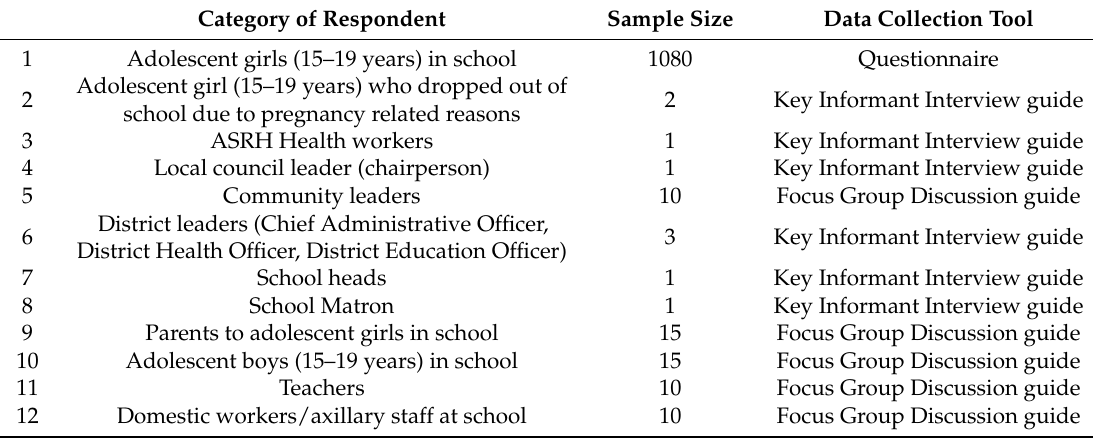
Table 1. Categorization of study respondents. ASRH: Adolescent Sexual and Reproductive